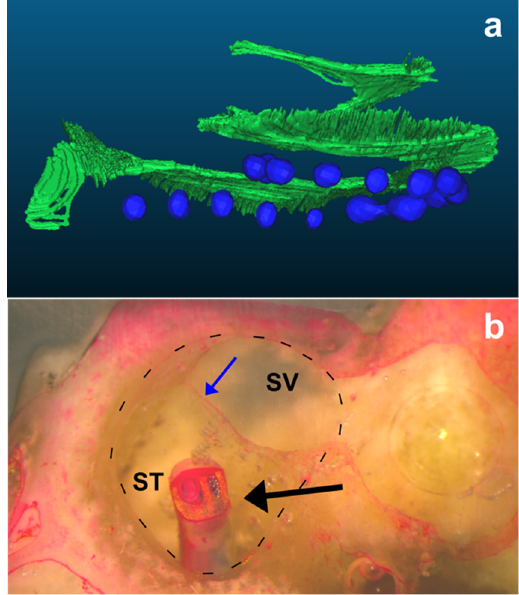
Figure 5. The middle plane of the cochlear turn reconstruction and histologic techniques were used to assess the position of each electrode array. ( a ) The “basilar membrane” reconstruction, including the basilar membrane and spiral lamina, was selected based on the dimensions of the cochlea analyzed; ( b ) the microgrinding technique shows the electrode array penetrating the scala tympani. The black discontinuous lines delimit the cochlear duct. ST: scala tympani; SV: scala vestibuli; black arrow: electrode array; blue arrow: basilar membrane.